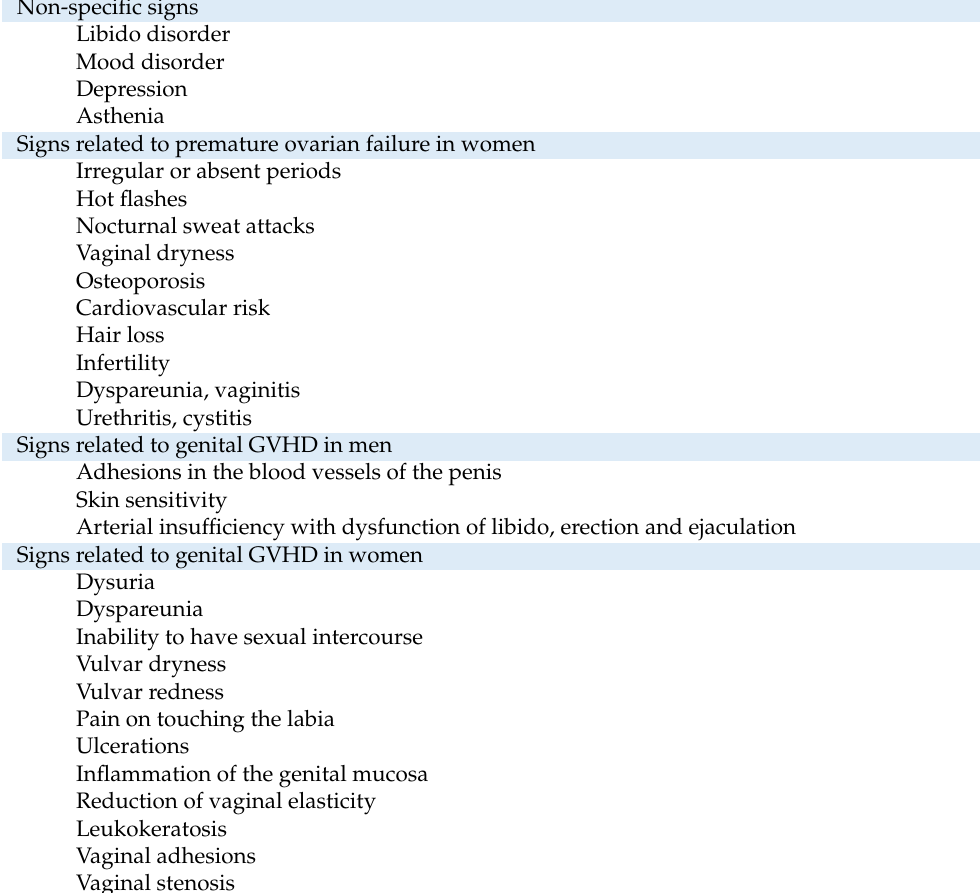
Table 1. Sexual dysfunctions after allogeneic